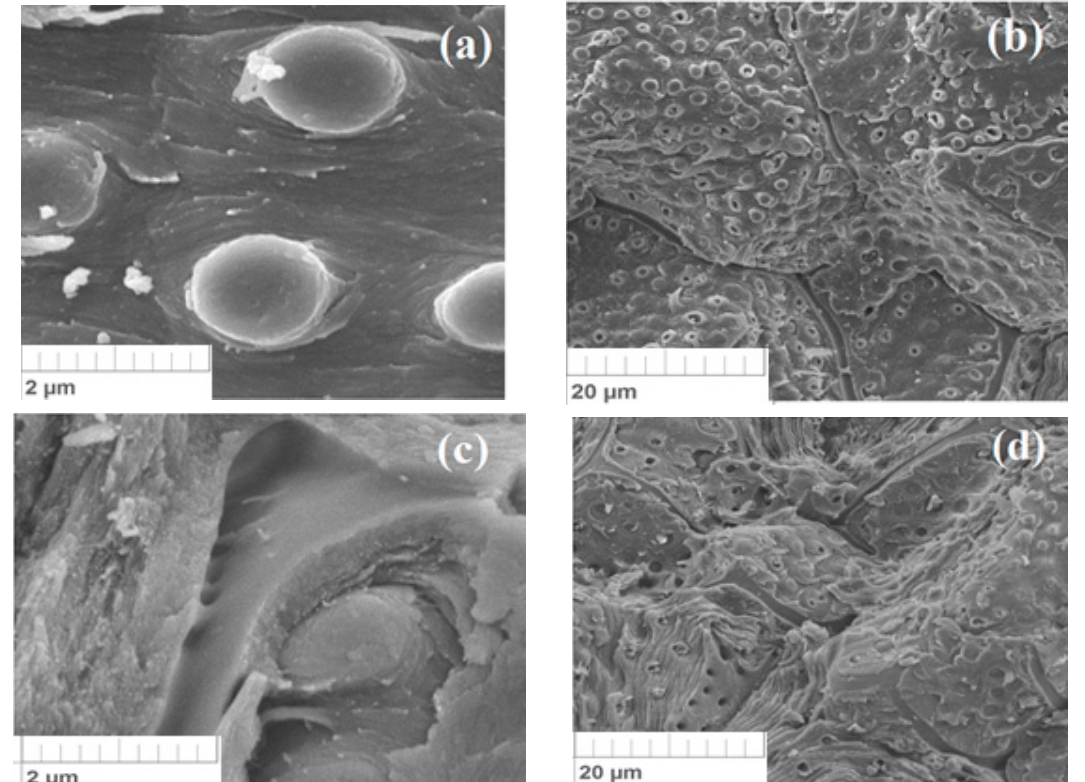
Figure 4. SEM analysis of the microstructure of surfaces of original ( a , b ) and burnt ( c , d ) apricot kernel shell biomass.